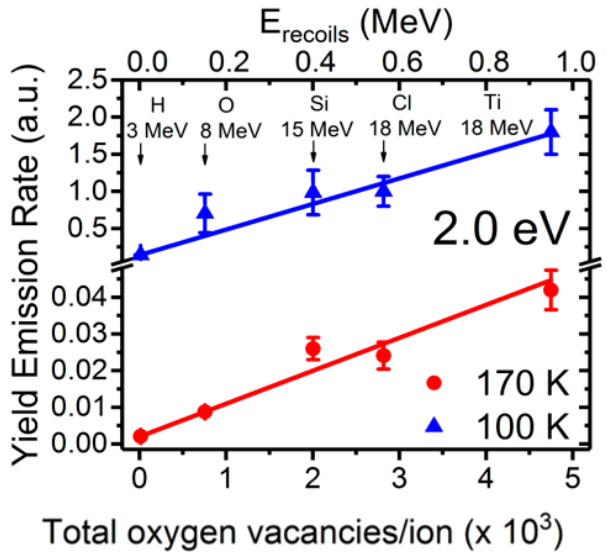
Figure 6. Normalized initial growth rate of the 2.0 eV emission band in SrTiO 3 , associated with isolated oxygen vacancies, as a function of the vacancy production rate calculated by the SRIM code [37] under irradiation with several high-energy ions and energies (see labels). A clear linear correlation is observed for all the ions at both temperatures. This figure has been adapted from Crespillo et al. [25], Copyright (2018), with permission from Elsevier.